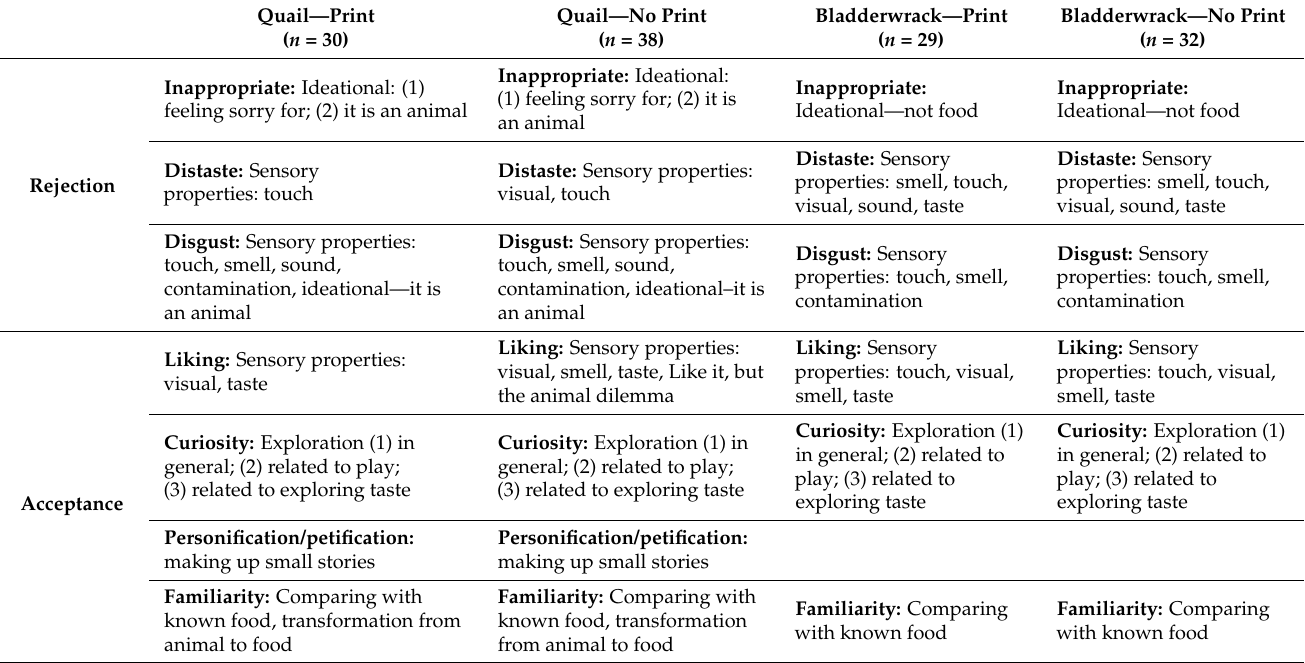
Table A1. Thematic scheme across cases.